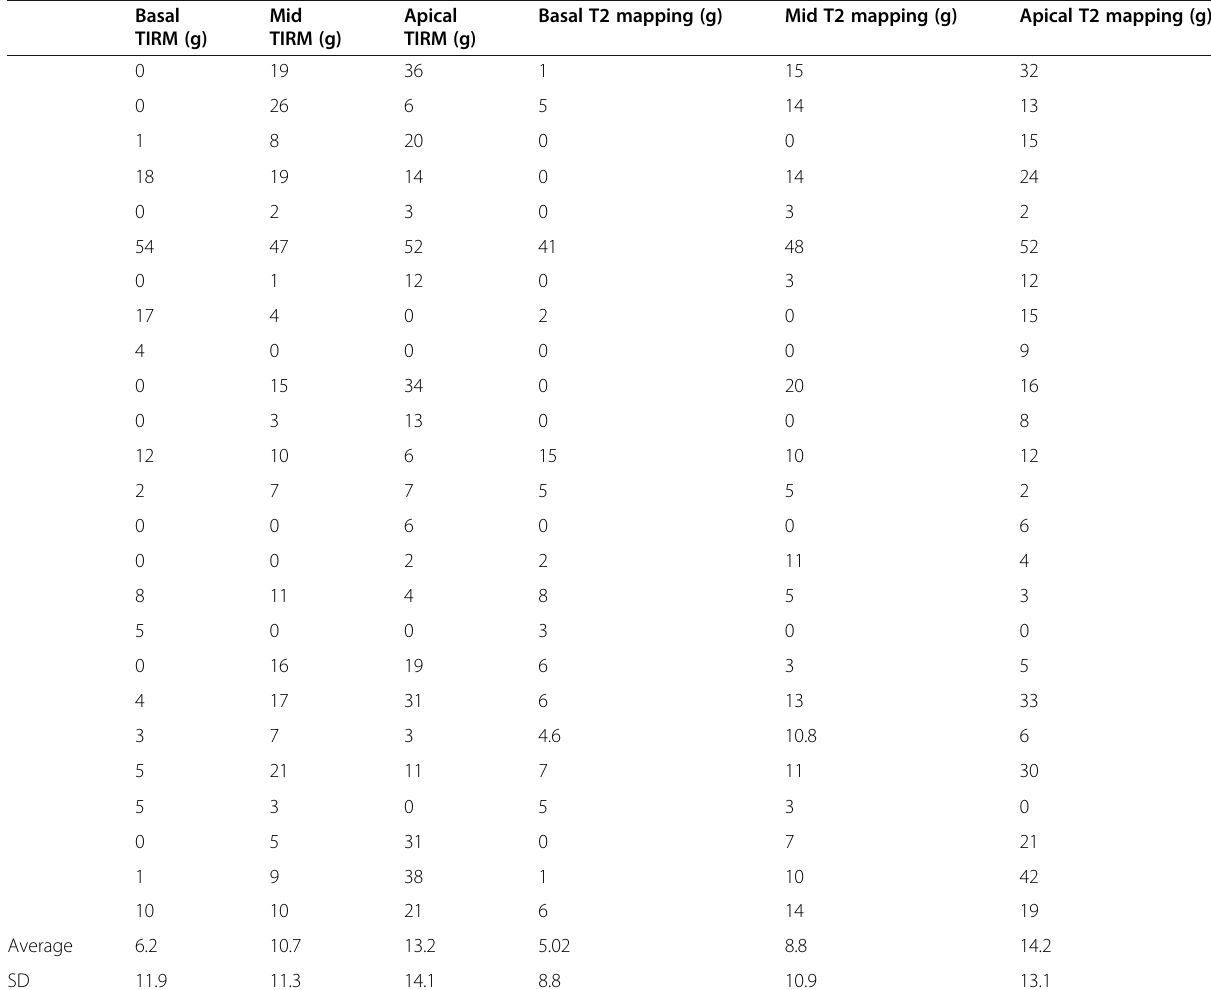
Table 2 Myocardial segmental agreement of the edema sequences Basal Mid Apical TIRM (g) TIRM (g) TIRM